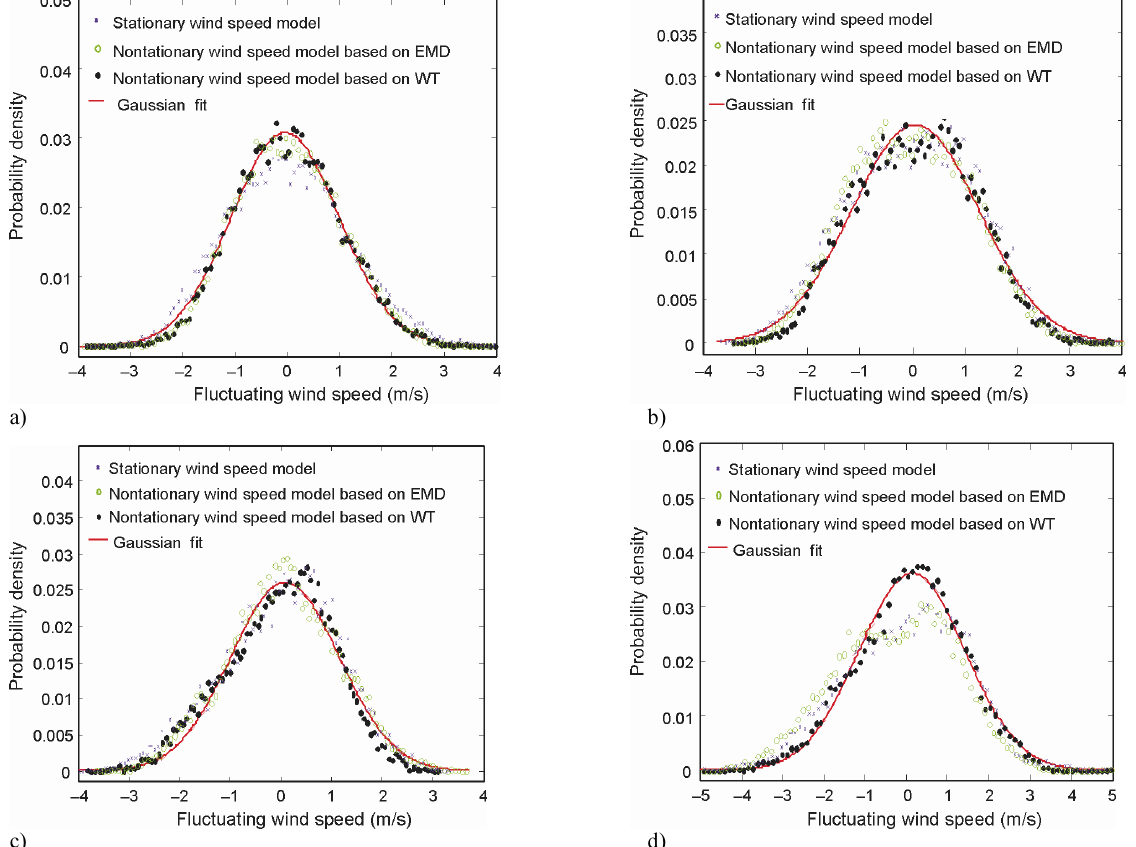
Fig. 4. Comparison of probability densities: (a) deck level wind speed sample (16:51–21:36, 1 April 2003); (b) deck level wind direction sample (22:10–02:48, 1–2 April 2003); (c) tower top wind speed sample (16:51–21:36, 1 April 2003); (d) tower top wind direction sample (22:10–02:48, 1–2 April